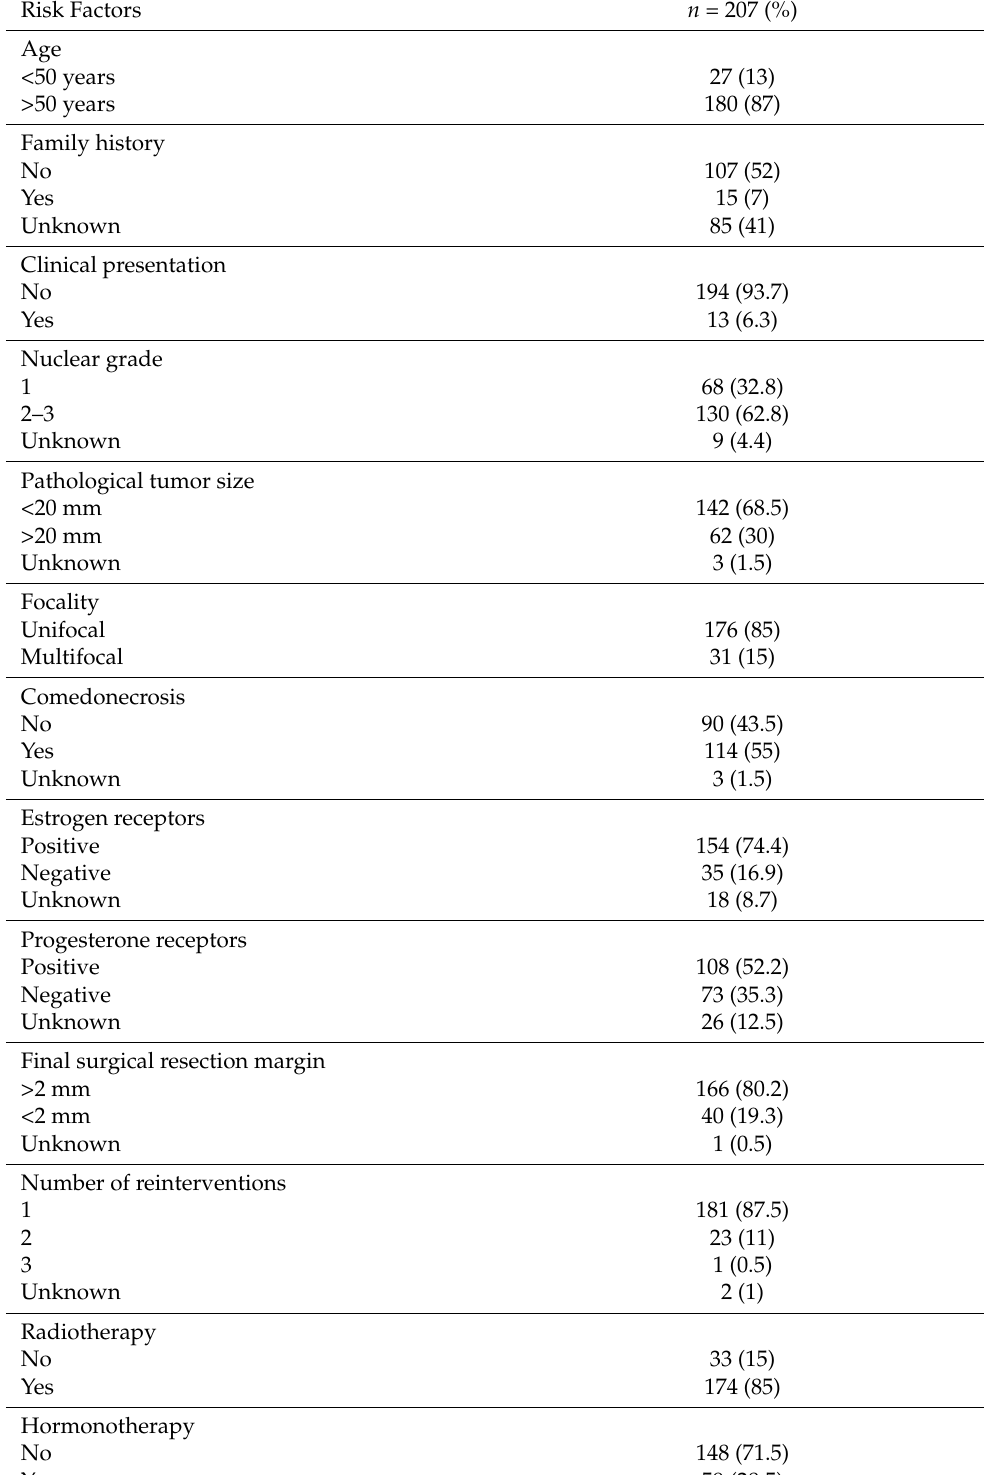
Table 1. The clinicopathologic characteristics of patients with DCIS treated with